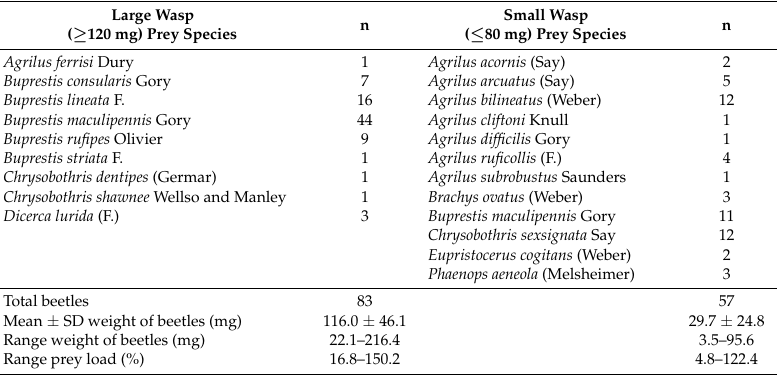
Table 3. Comparison of the identity, number, and weight of prey Buprestidae collected by large ( ≥ 120 mg) vs. small ( ≤ 80 mg) Cerceris fumipennis at eight study sites (pooled) in North